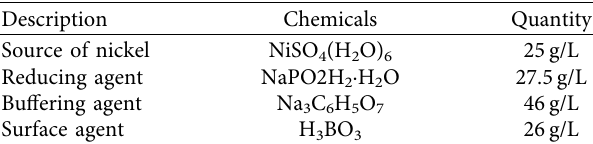
Table 2: Chemicals required for electrolyte